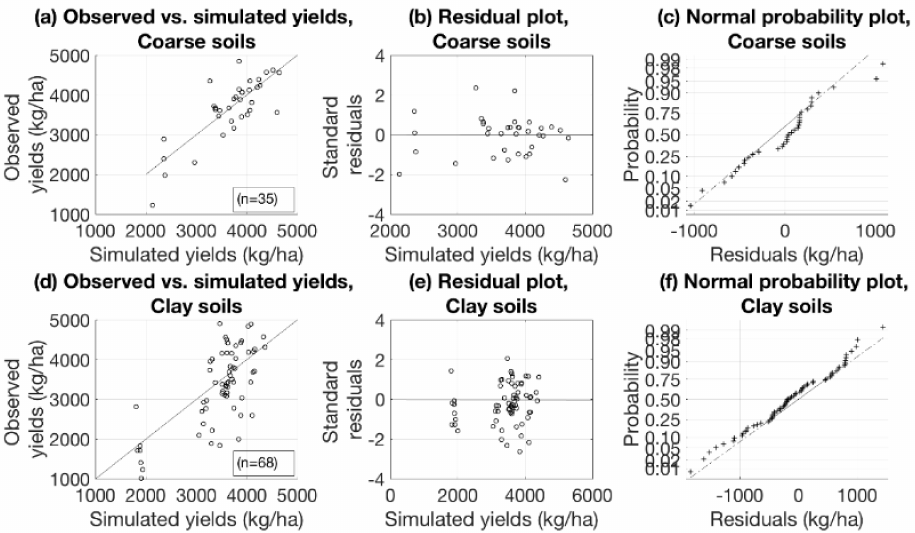
Figure 4. Graphical model validation results for ( a – c ) coarse-textured soils and ( d – f ) clay